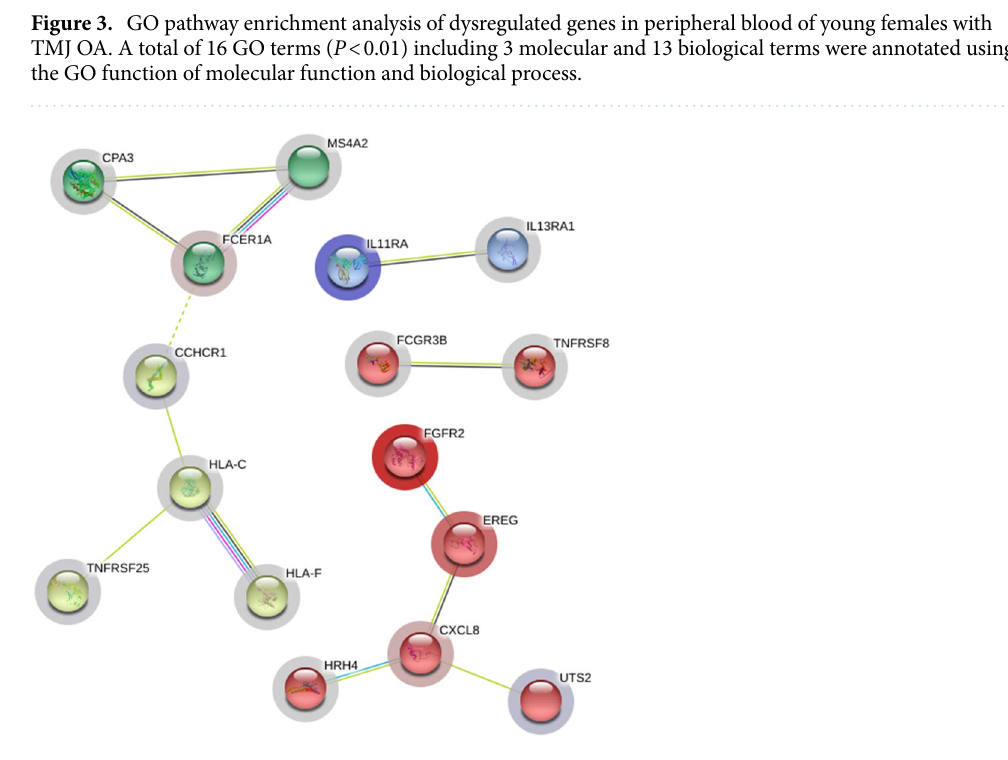
Figure 4. Four clusters of strong functional associations with significant levels of network enrichment. The figure was obtained from STRING portal (http:// string- db. org, version